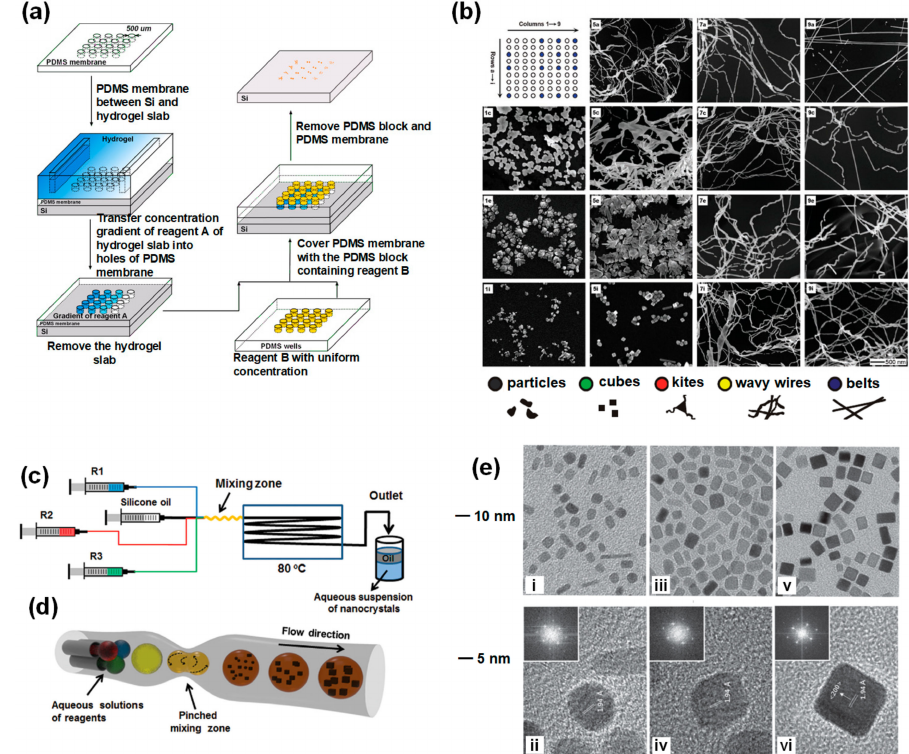
Figure 2. ( a ) Schematic of the fabrication process of a high-throughput array reactor for screening Au nanostructures. The synthesis of Au nanostructures involves the mixing of the HAuCl 4 solution with cetyltrimethylammonium bromide (CTAB) solution. Then, addition of the L-ascorbic acid solution reduces Au to Au(I), and addition of NaOH at Au(I) state boosts the reducing power of L-ascorbic acid to further reduce Au(I) to elemental Au. ( b ) Scanning electron microscopy (SEM) images of Au nanostructures that were formed in a two-dimensional array of reactors with gradients for the concentrations of NaOH and CTAB. Reproduced with permission from [61]. Copyright John Wiley and Sons, 2011. ( c ) High-throughput droplet platform integrated with the mixing tube ( d ) for screening the synthesis of Pd. The preparation of Pd nanocrystals involves the reduction of Na 2 PdCl 4 by L-ascorbic acid in an aqueous solution at 80 ◦ C, in the presence of KBr and poly(vinyl pyrrolidone) (PVP); ( e ) Transmission electron microscope (TEM) (i,iii,v) and high resolution transmission electron microscope (HRTEM) images (ii,iv,vi) of Pd nanocrystals with di ff erent morphologies. Reproduced with permission from [84]. Copyright John Wiley and Sons,